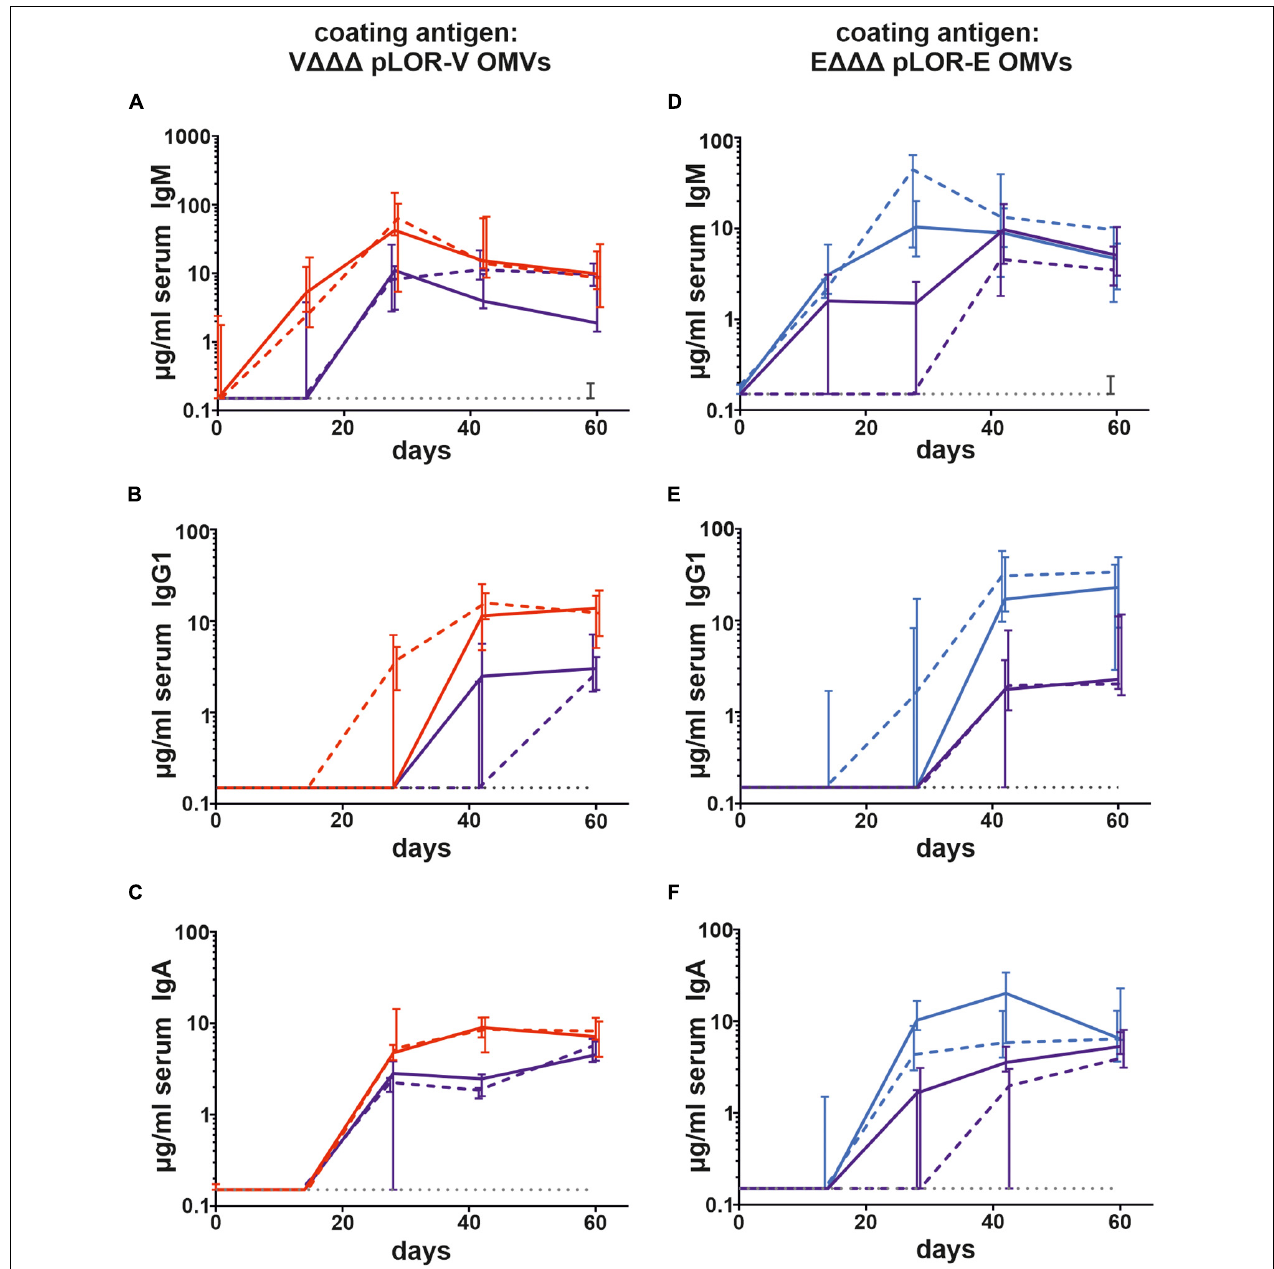
FIGURE 3 | Temporal immune responses to V. cholerae and ETEC OMVs. Shown are the median titers over time of IgM (A,D) , IgG1 (B,E) , and IgA (C,F) antibodies to OMVs derived from V (cid:49)(cid:49)(cid:49) pLOR-V (A–C) and E (cid:49)(cid:49)(cid:49) pLOR-E (D–F) in sera from mice intranasally immunized with OMVs derived from V (cid:49)(cid:49)(cid:49) pLOR-V (red solid line), V (cid:49)(cid:49)(cid:49) p (red dashed line), E (cid:49)(cid:49)(cid:49) pLOR-E (blue solid line), E (cid:49)(cid:49)(cid:49) p (blue dashed line), and from the sham-immunized control group (gray dotted line). Moreover, two groups were intranasally immunized with alternating regimen and received OMVs from E (cid:49)(cid:49)(cid:49) pLOR-E on days 0 and 28 as well as OMVs from V (cid:49)(cid:49)(cid:49) pLOR-V on day 14 (EVE pLOR-E/V, purple solid line) or OMVs from E (cid:49)(cid:49)(cid:49) p on days 0 and 28 as well as V (cid:49)(cid:49)(cid:49) p on day 14 (EVE p, purple dashed line). Samples which did not yield in any detectable signal at their highest concentration were set to the limit of detection (0.15 µ g/ml). The error bars indicate the interquartile range of each data set for each time point ( n = 7 for each